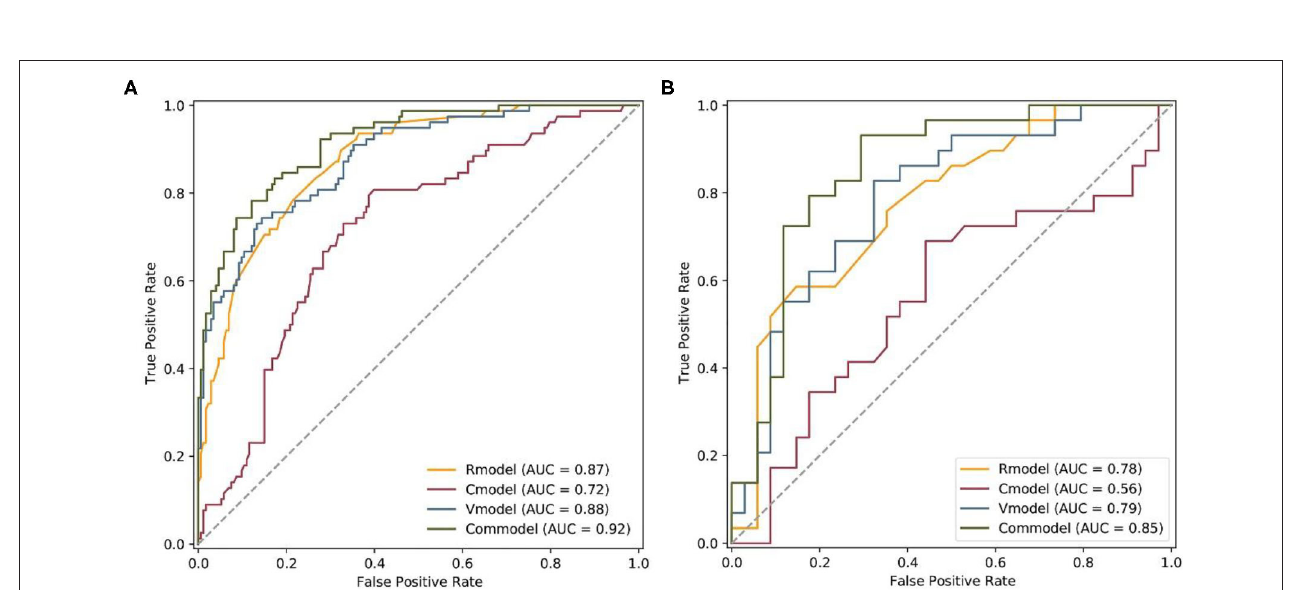
FIGURE 5 | Comparison of ROCs between the Rmodel, Cmodel, Vmodel, and Commodel for the prediction of AF subtype in the (A) training and (B) validation cohorts. Rmodel , radiomics signature model; Cmodel , clinical model; Vmodel , the model based on volume values; Commodel , the model combined with both radiomic features and volume